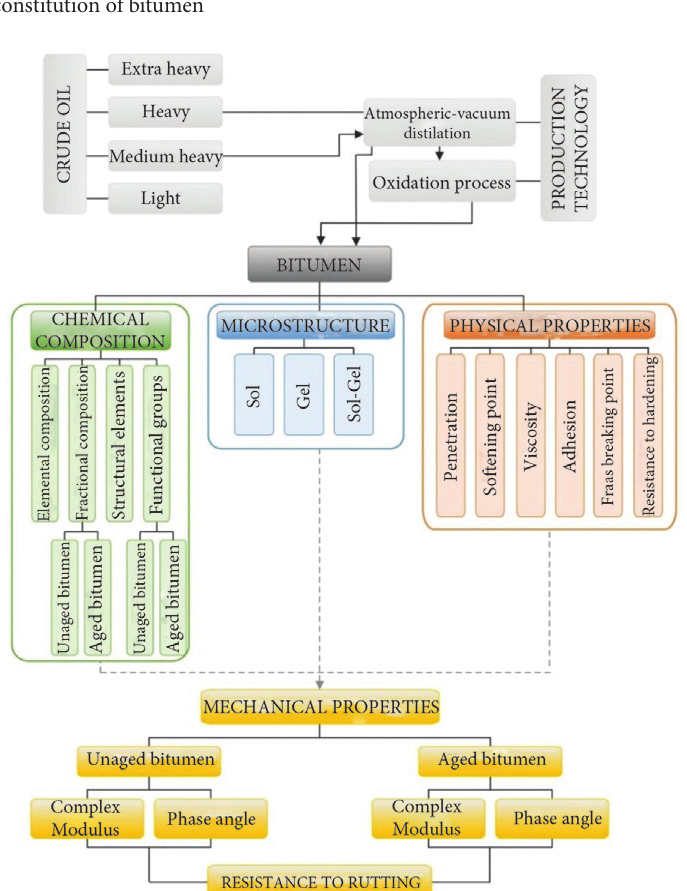
fig. 4. A scheme of experimental